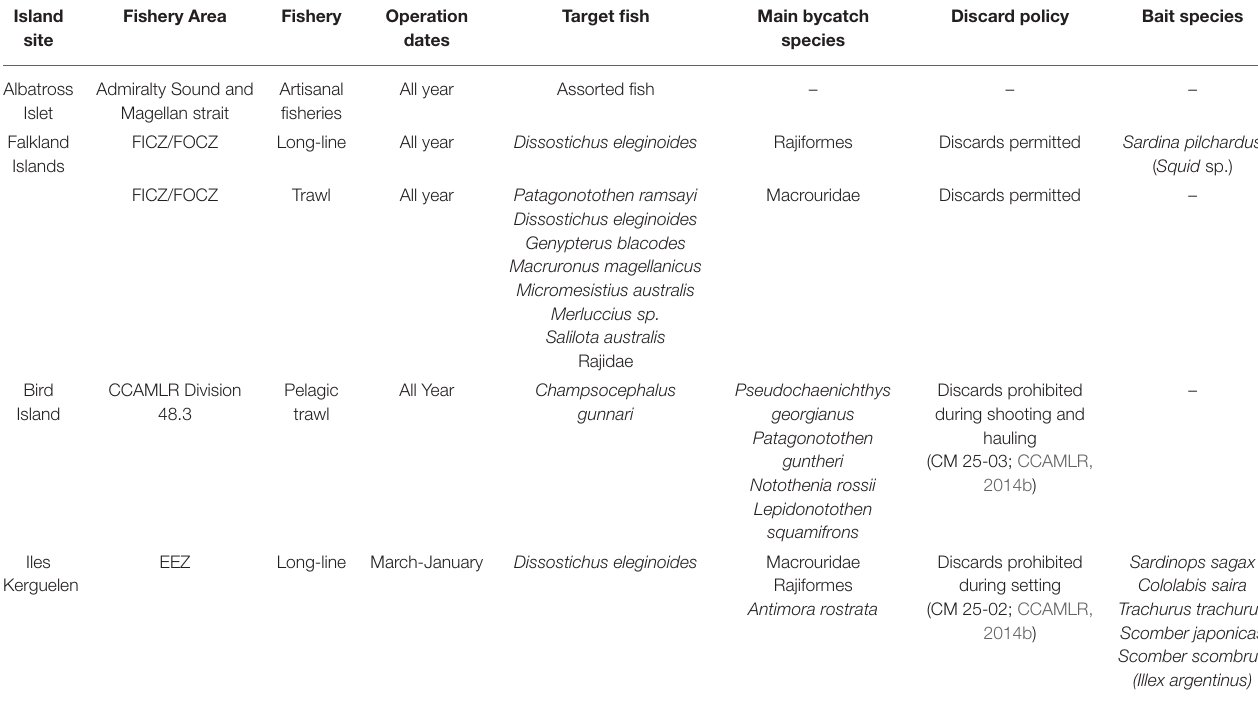
TABLE 3 | Details of commercial fisheries operating in waters adjacent to breeding colonies of black-browed albatrosses during the sampling periods. Island